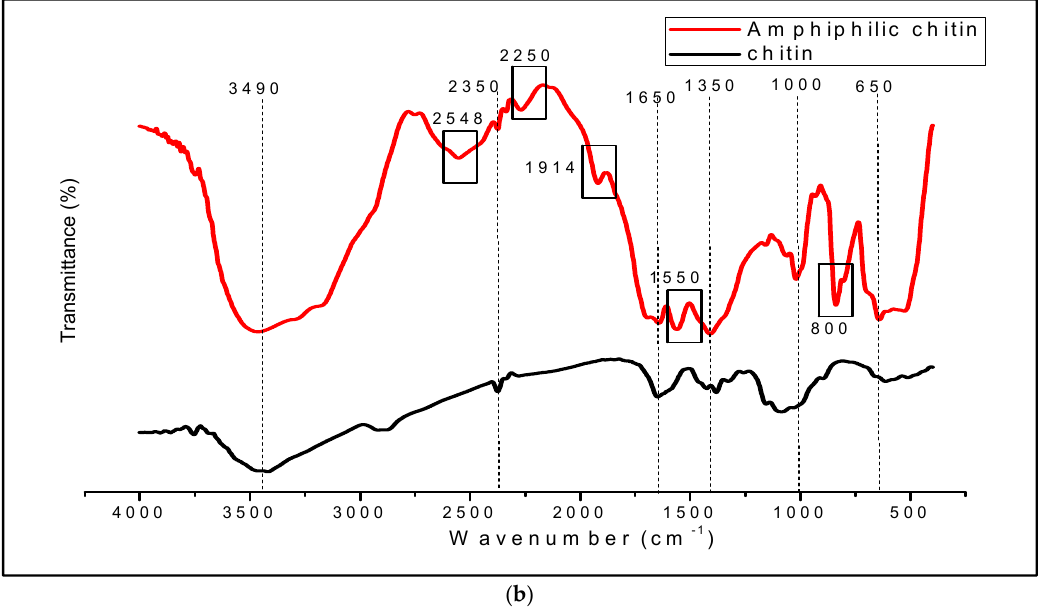
Figure 1. ( a ) Schematic chemical reaction of preparation of amphiphilic chitin. ( b ) FT-IR graph of amphiphilic chitosan and conventional chitosan.